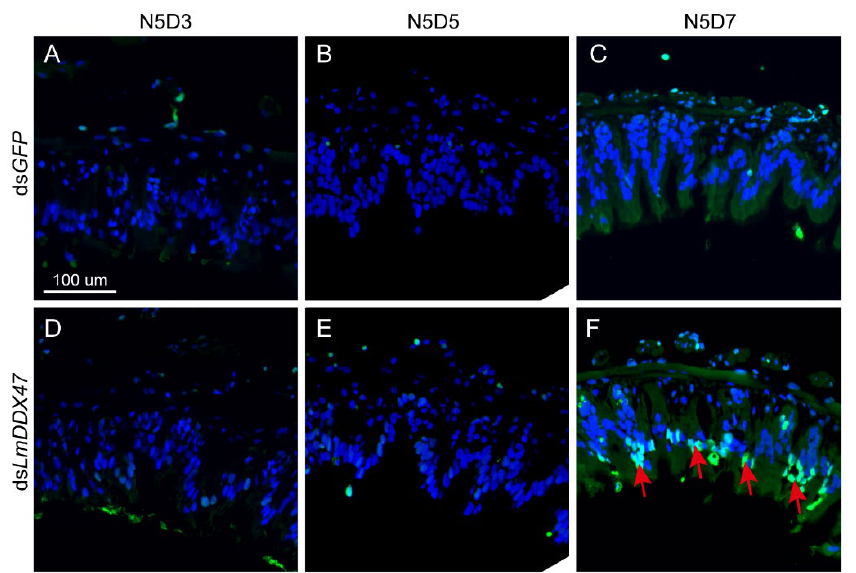
Figure 7. LmDDX47 knockdown results in cell death in midgut columnar cells. ( A – F ) A TUNEL assay of the midgut of N5D3 ( A , D ), N5D5 ( B , E ), and N5D7 ( C , F ) nymphs after ds GFP and ds LmDDX47 injections. Blue represents the nucleus, and red arrows pointing to the green fluorescence indicate the site of cell death in columnar tissue. Scale bar = 100 μm, n = 3.